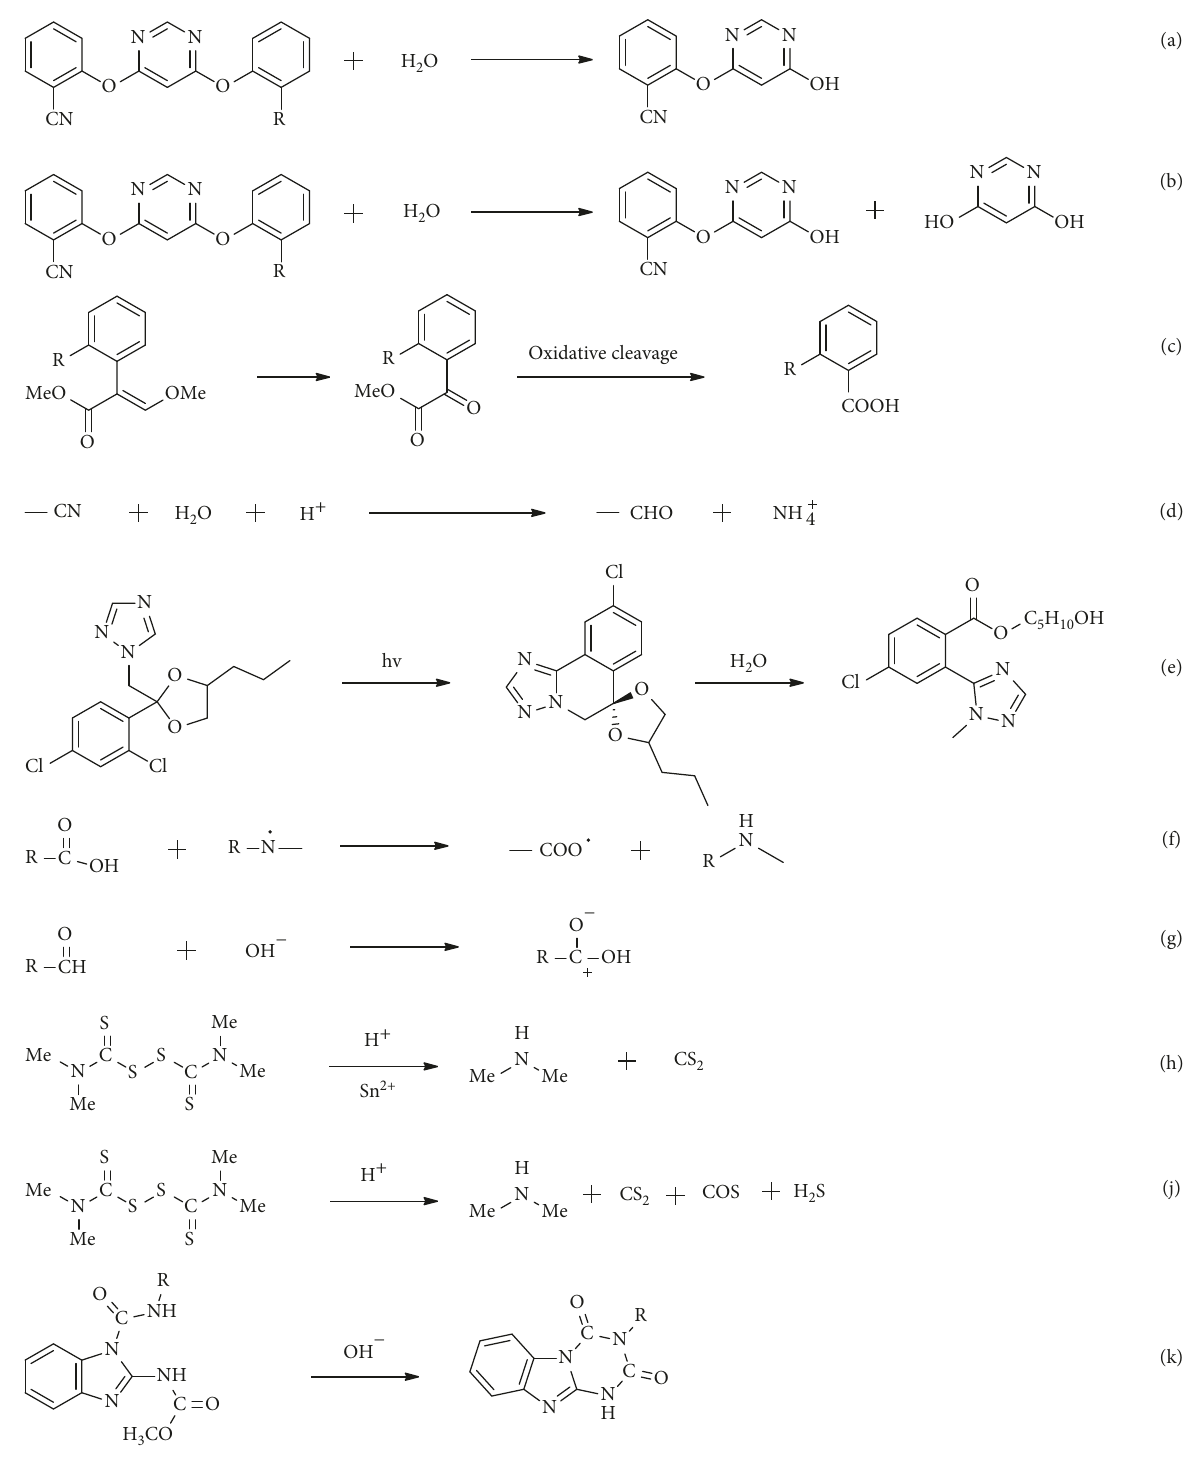
Figure 2: Degradation pathways of